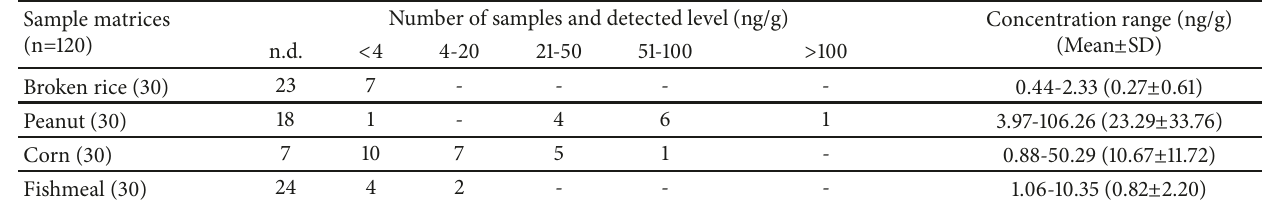
Table 2: Occurrence and levels of AFB 1 contamination in